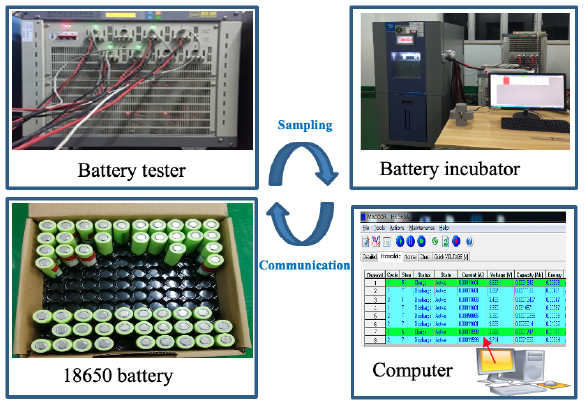
Figure 3. Schematic diagram of the battery experiment